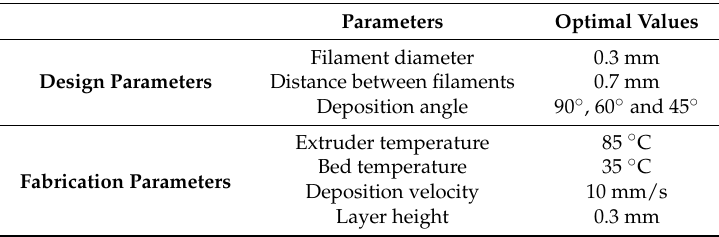
Table 1. Optimal process parameters values used for PCL scaffold printing.